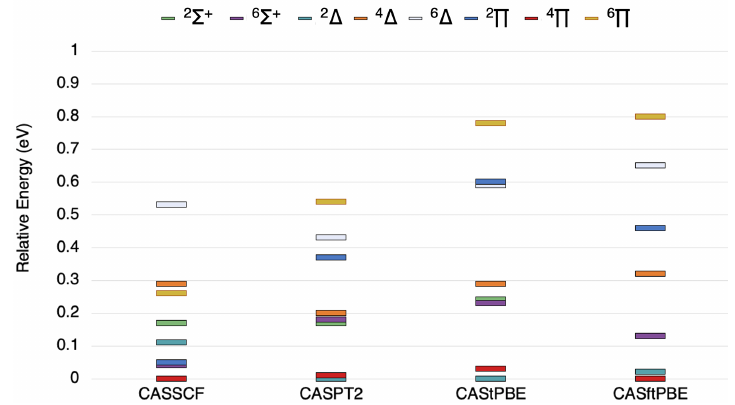
Figure 1. The state ordering (in eV) of the lowest 6 Σ + , 2 Σ + , 6 ∆ , 4 ∆ , 2 ∆ , 6 Π , 4 Π , and 2 Π states of VSi as computed by the methods